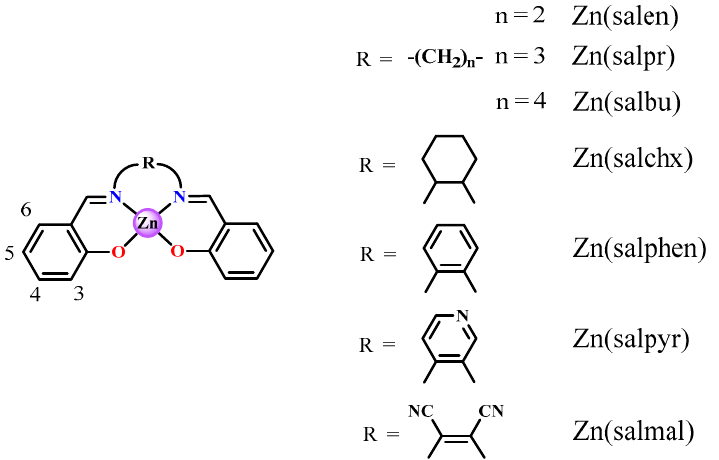
Figure 1. Some basic structures of Zn(salen)-type complexes and abbreviations used.